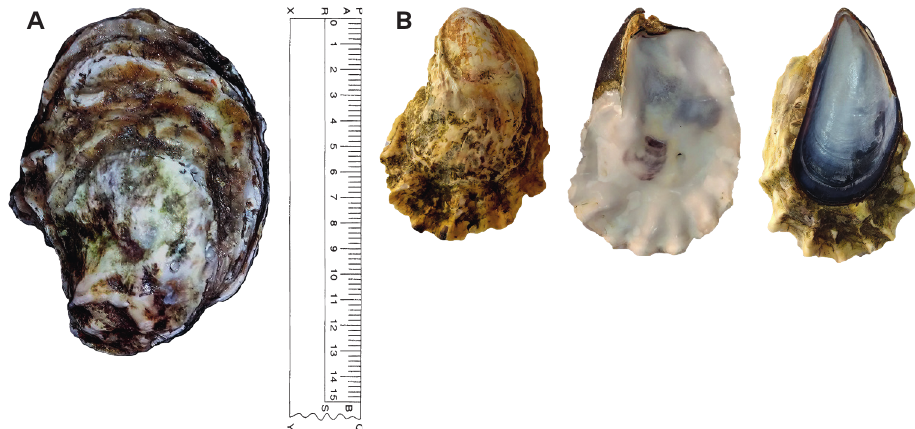
Figure 3 . Magallana gigas specimens from the Romanian Black Sea waters (scale in cm). (A) The larg- est collected specimen; (B) Medium sized